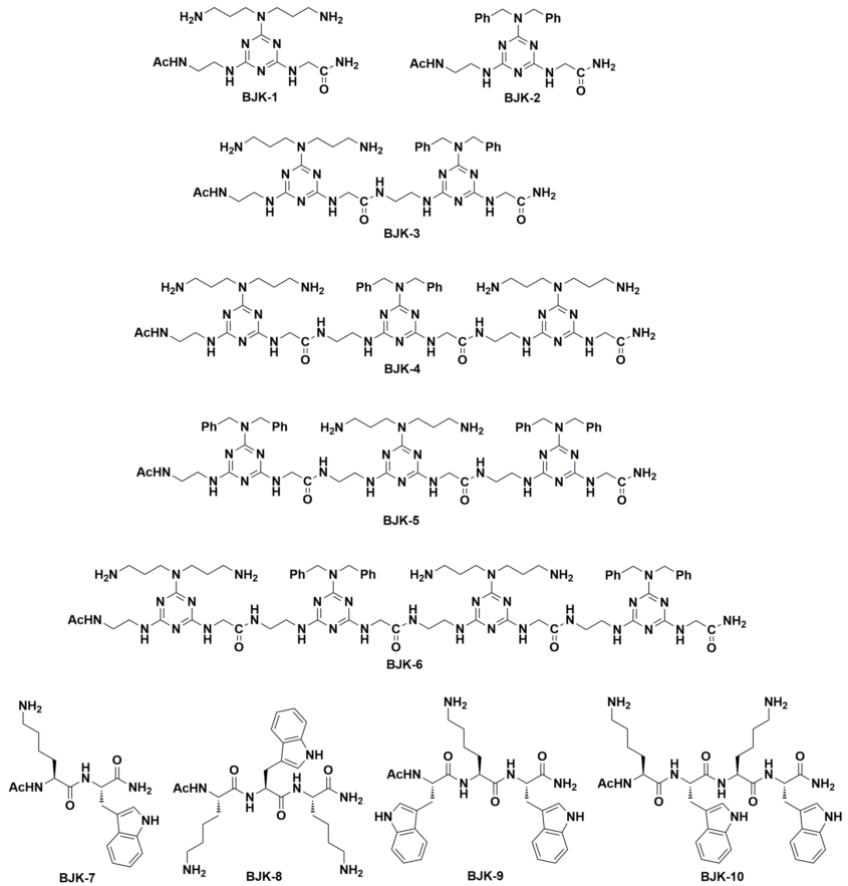
Figure 2. Structures of peptidomimetics derived from the Fmoc-triazine amino acids BJK-(1-6) and peptides derived from Lys and Trp, BJK-(7-10) .